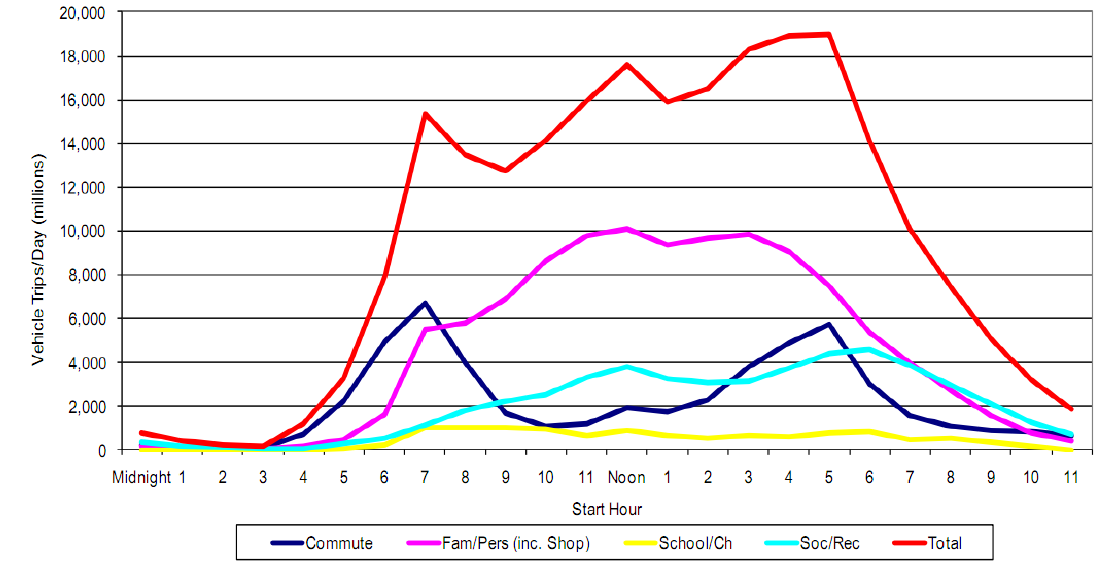
Figure 4. Distribution of vehicle trips by trip purpose and start